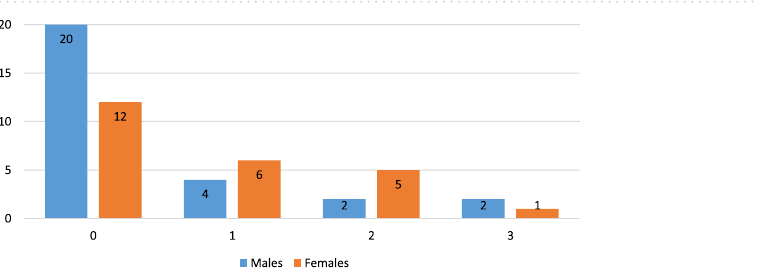
Figure 5. The number of mating periods that reintroduced, sexually mature Eurasian lynx survived in the wild from September 2019 to September